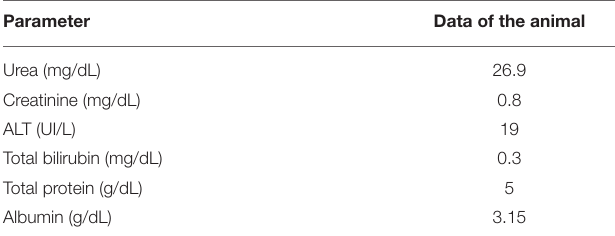
TABLE 2 | Preoperative biochemistry.